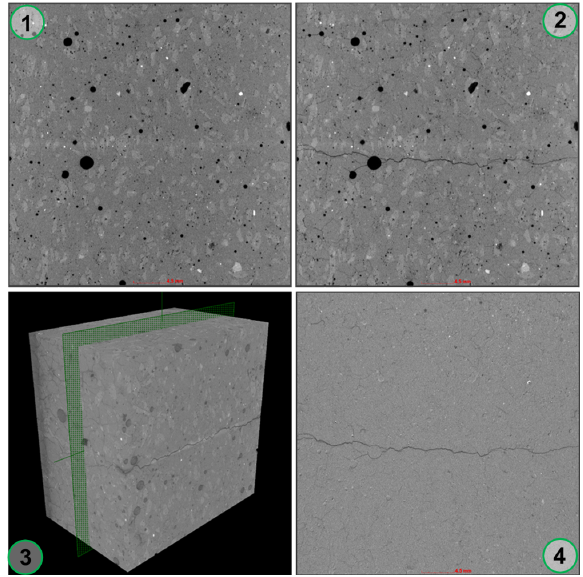
Figure 7. Visualization of tomographic cross-sections taken in the same place perpendicular to the direction of the crack propagation ( xz plane). 1) Visualiza- tion of the cross-section before three-point bending; 2) Visualization of the cross-section after three point bending; 3) Plane representing the position of the visualized cross-sections (orientation of the volume corresponds to Figure 3); 4) Differential image with highlighted differences (cracks).